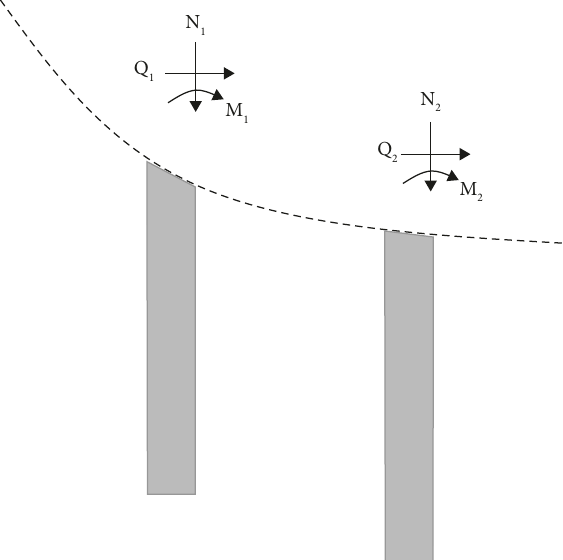
Figure 10: Calculation diagram of the anchorage section.